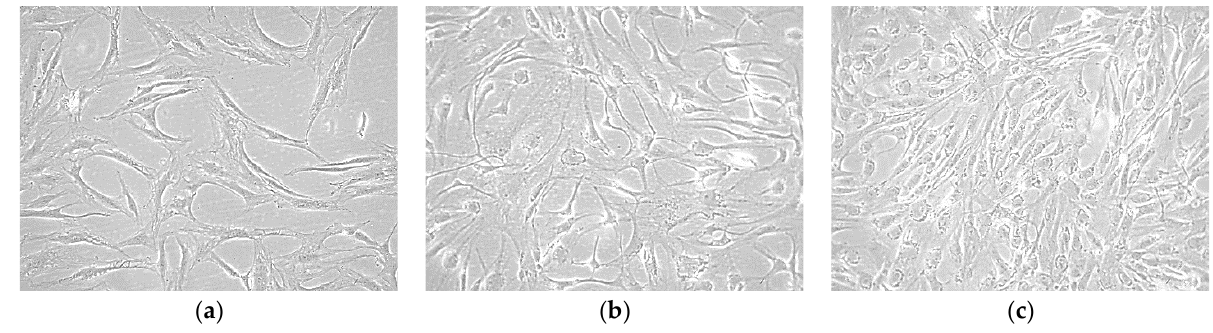
Figure 3. Bright field microscopic images of the hPDCs cultured in tissue flasks (growing on the bottom of the tissue flasks): ( a ) low cell culture confluency one day after cell seeding, ( b ) medium cell culture confluency four days after cell seeding, ( c ) high cell culture confluency seven days after cell seeding. Table 4. Cell expansion results from the reference experiment. Number of cells counted, total amount of accumulated lactate produced (mM), total amount of medium supplied (mL) and the overall medium efficiency (cells/mL).